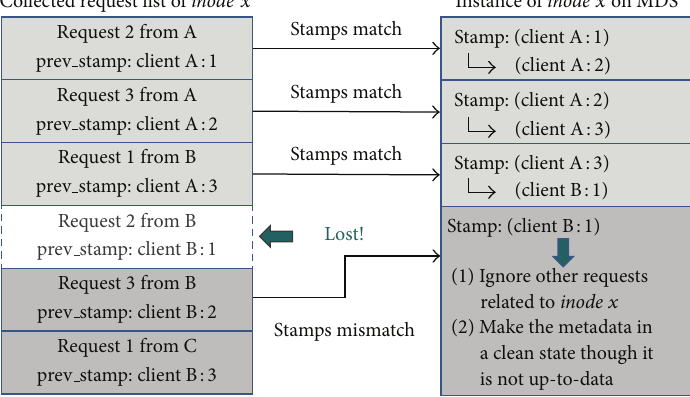
Figure 3: Stamp-based metadata